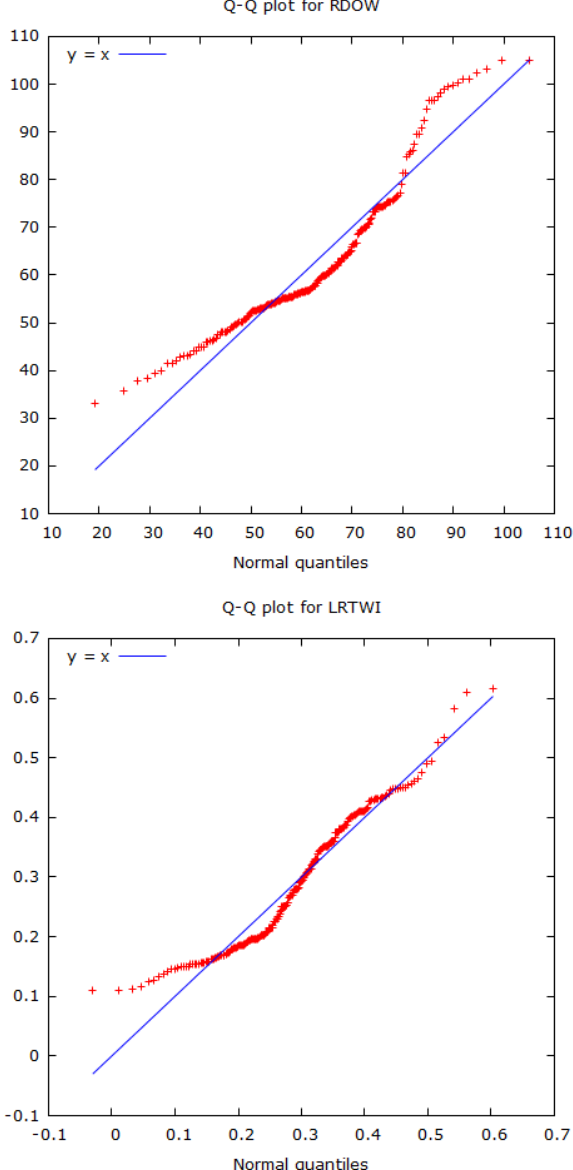
Figure 2. QQ plots of real values of the Dow Jones Index and WTI Crude Oil